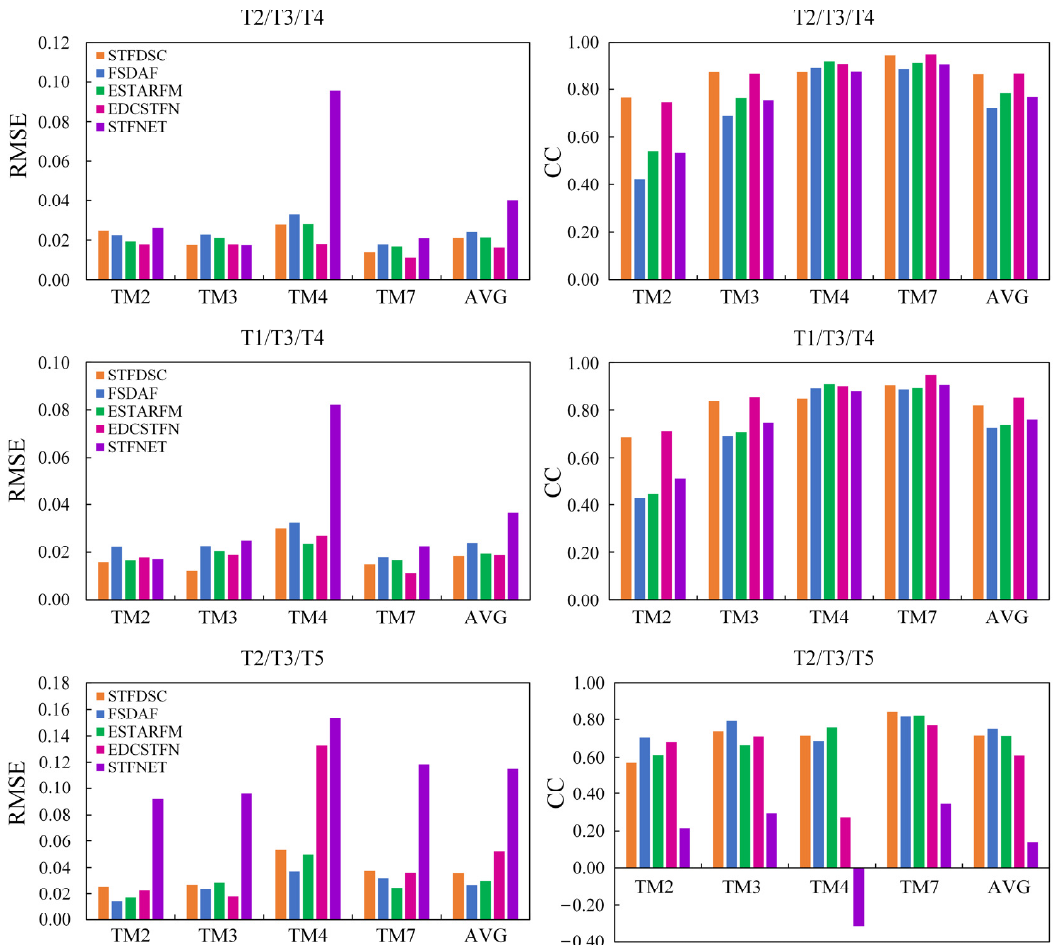
Figure 3. Performance of five STF methods in reconstructing Landsat surface reflectance in the ZWL. Among the three experiments in the GKM, input data of Experiment T2/T3/T4 were Landsat data at T2 and T4 and MODIS data from T2-T4 acquired the closest to T3. The STFDSC results were much closer to the Landsat reference data than ESTARFM, FSDAF, EDCSTFN, and STFNET. For all four TM bands, the surface reflectance predicted by STFDSC had the lowest RMSE and highest CC values. In addition, STFDSC also corresponded to the lowest SAM index, 0.0219, suggesting the optimal accuracy achieved (Figures 4 and 5). In Experiment T1/T3/T4, STFDSC still produced the most accurate synthetic image with an average RMSE of 0.0132 and CC of 0.8266. The surface reflectance generated by EDCSTFN was observed to be abnormal at TM band 3, partly due to its sensitivity to data preprocessing. We tried bilinear interpolation instead of the nearest neighbor method to preprocess the MODIS data and found that it performed normally in the GKM. The main reason for the observed abnormal phenomena was probably that the mean reflectance at TM band 3 was 0.0304, substantially lower than 0.3036 at TM band 4 and 0.0615 at band 7, and fluctuations existed in predicting lower reflectance by EDCSTFN. In this study, the loss function adopted the weighted average method, in which bands with smaller mean reflectance were assigned a larger weight to avoid substantial prediction error at TM band 3; therefore, compared with EDCSTFN and STFNET, STFDSC produced a more stable and accurate results, which also suggested its better performance in generating Landsat surface reflectance. In Experiment T2/T3/T5, STFDSC still achieved the best prediction accuracy, with an average RMSE of 0.0081, CC of 0.9314, and SAM of 0.0228 (Figures 4 and